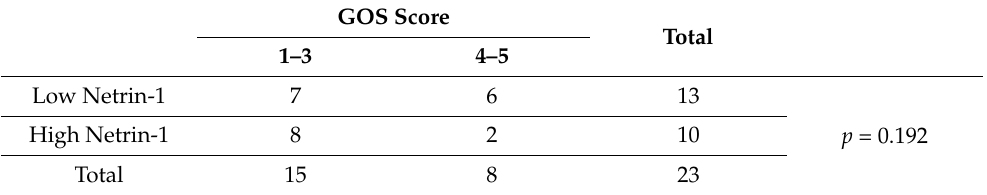
Figure 5. Serum Netrin-1 levels did not evaluate prognosis, while the expression of DCC receptors reflected the prognosis of TBI. ( a ) Differences in terms of serum Netrin-1 concentrations between poor prognosis group (GOS 1–3 points) and good prognosis group (GOS 4–5 points). ( b ) Receiver operating characteristic curve for analyzing predictive ability regarding protein concentration of DCC receptors and serum Netrin-1 concentrations for poor prognoses. Table 6. Comparison of GOS level between the high Netrin-1 group and the low Netrin-1 group.